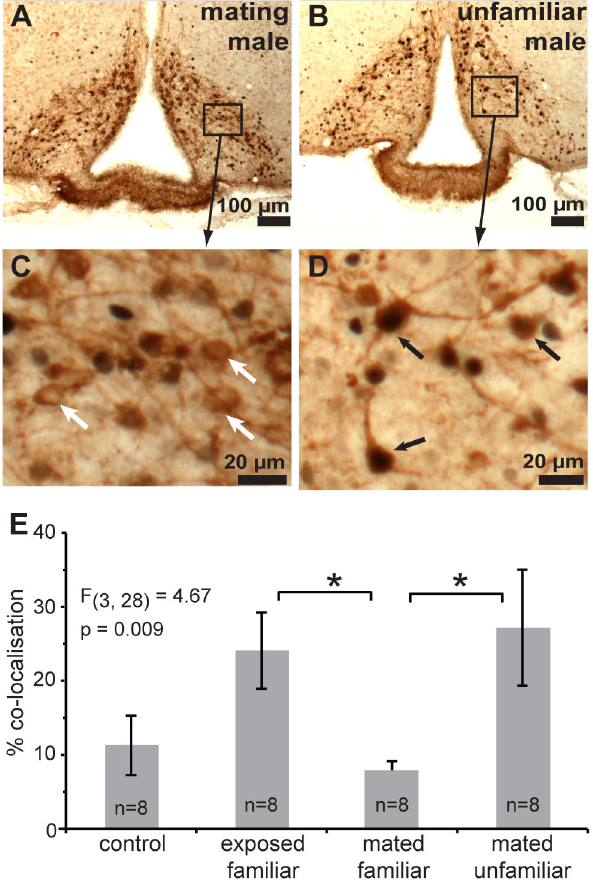
Figure 1. Mating suppresses the effectiveness of mating male’s chemosignals in activating arcuate dopaminergic neurons. Significantly lower co-localisation of c-Fos (black nuclei) was found in dopaminergic arcuate neurons (brown cytoplasm) of mated females exposed to familiar (mating) male bedding (A, C), than to bedding from an unfamiliar male (B, D). Black and white arrows indicate tyrosine hydoxylase-positive neurons with and without c-Fos co-localisation respectively. E) Mean (± standard error) percentage of arcuate dopaminergic neurons with c-Fos co-localisation was significantly lower in mated females exposed to the mating male compared to an unfamiliar male, or unmated females re-exposed to male bedding (*p < 0.05, Tukey multiple